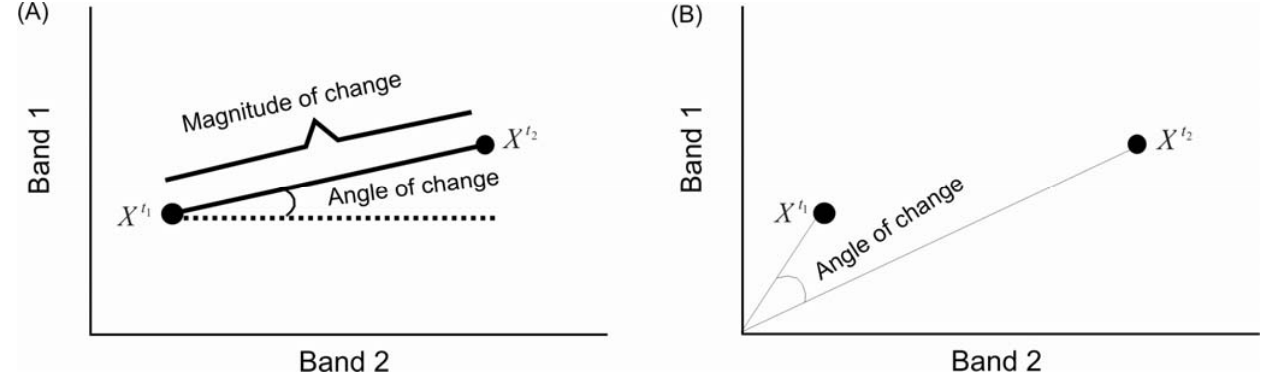
Figure 2. Two concepts in calculating the change angle of a pixel for the first ( t ) times: (a) magnitude and direction of change vector, relative to a projection of second ( t 2 the x axis (dotted line), from Malila (1980); and (b) angle of change between spectral vectors for a pixel X at t and t 1 2